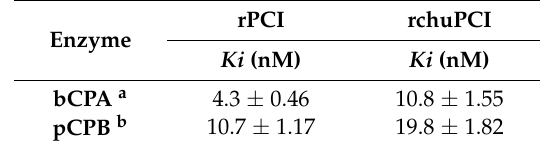
Table 1. Inhibition kinetic constants ( Ki ) of rPCI and recombinant churqueña PCI (rchuPCI) for